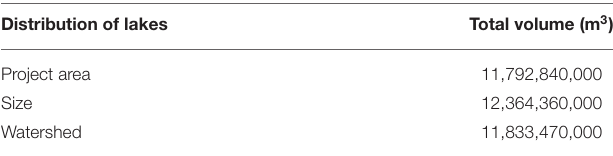
TABLE 6 | Comparison of total volume of the 40,054 lakes based on three approaches of Heathcote et al. (2015) method (Mille Lacs Lake not included). Distribution of